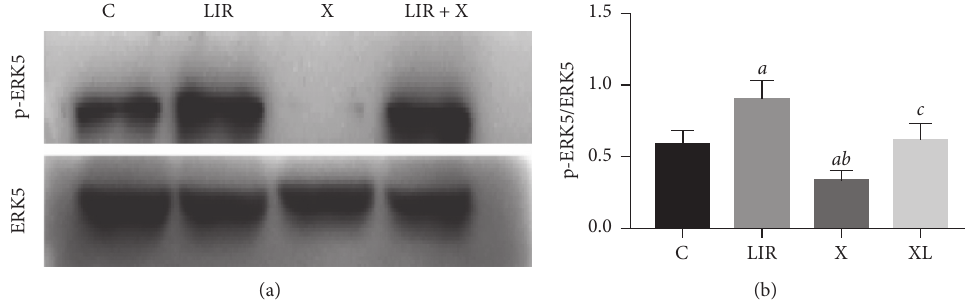
Figure 7: XMD8-92 inhibited the protective effect of liraglutide in MC3T3-E1 cells. The protein expression of p-ERK was detected by western blot after the MC3T3-E1 cells were pretreated with 10 μ M XMD8-92 for 1h, followed by 100nM liraglutide treatment for 48h (a). Quantitative analysis of the protein level of p-ERK5 (b) in MC3T3-E1 cells after pretreated with 10 μ M XMD8-92 for 1 h followed by 100nM liraglutide treatment for 48h. aP < 0.05 compared with control, bP < 0.05 compared with 100nM liraglutide, and cP < 0.05 compared with XMD8-92 group. C: control group; LIR: 100nM liraglutide; X: XMD8-92; X +LIR: XMD8-92 with 100nM